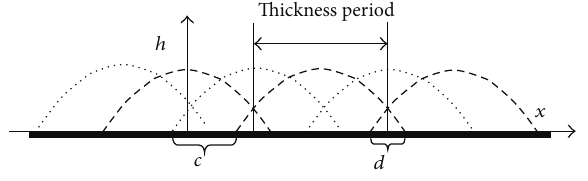
Figure 13: Coating thickness distribution when 𝑐 > 𝑑 , 𝑐 + 𝑑 > 0.5 and 𝑐 + 2𝑑 ≤ 1 .